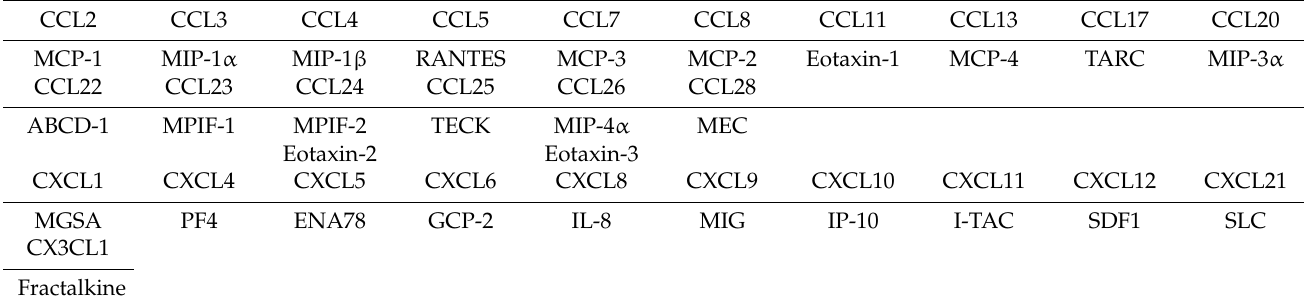
Table 2. Chemokines identified in schizophrenia (new and most popular old